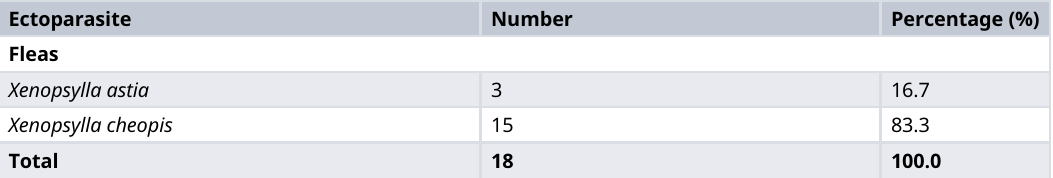
Table 3. Frequency distribution of ectoparasites in rats caught in West Jakarta, November